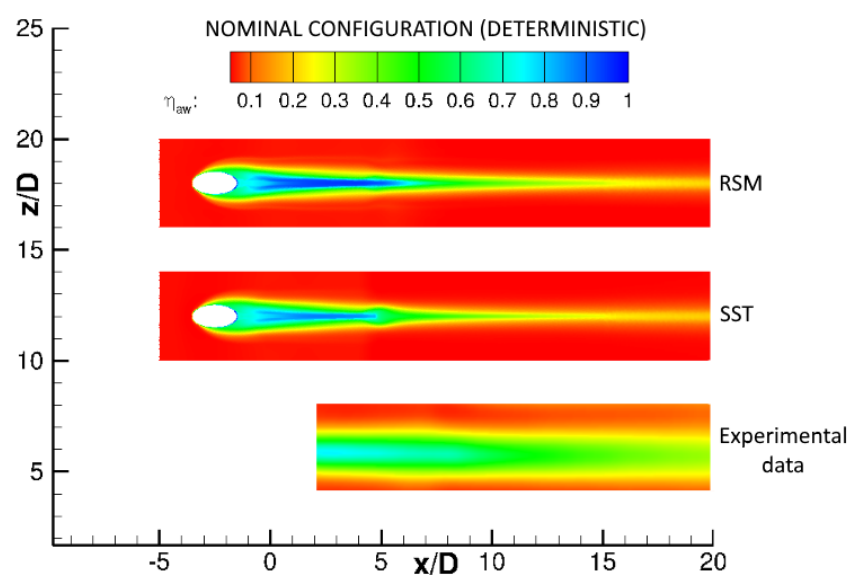
Figure 4. η aw experimental and numerical 2-D maps [21,30].